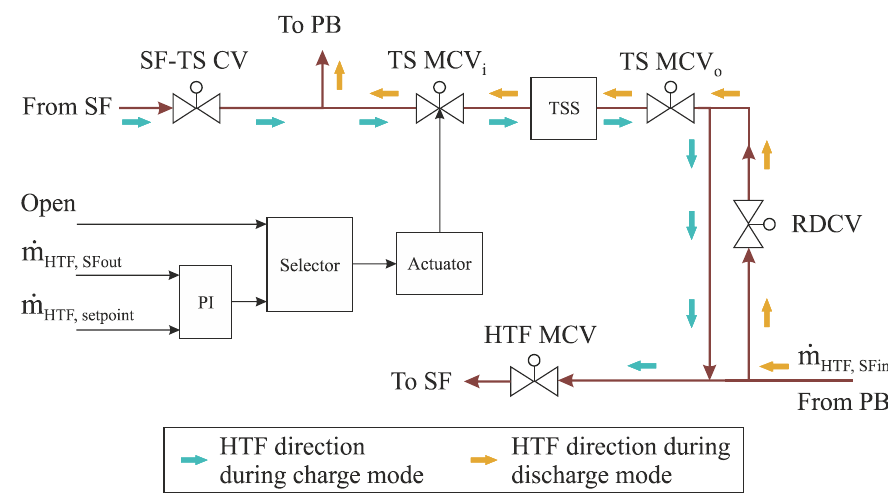
Figure 10. HTF control valve at the thermal storage inlet (simplified).